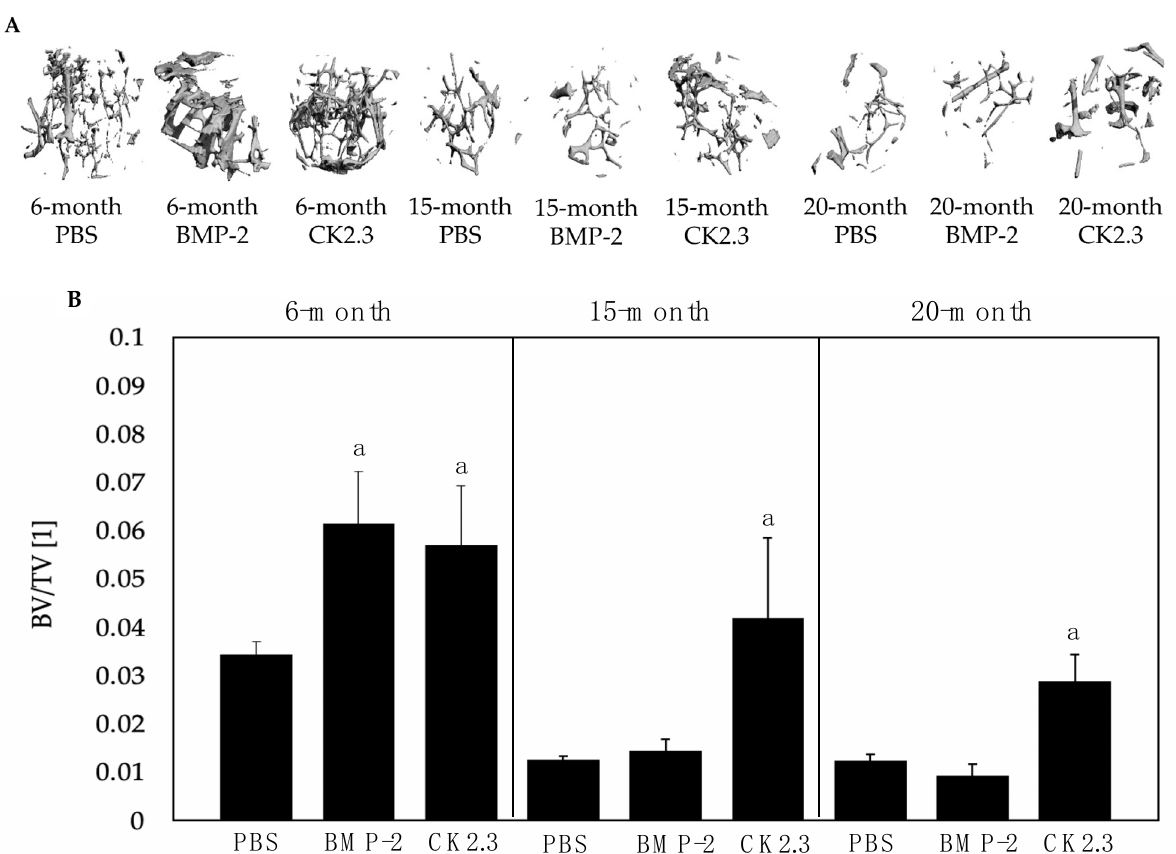
Figure 4. µ CT analysis of trabeculae of mice femurs. ( A ) µ CT images were obtained of femurs isolated from 6-, 15-, and 20-month-old mice stimulated with PBS, BMP-2, and CK2.3 ( N = 5/experimental group); 255 scans were taken of each bone and were reconstructed using a 200–1000 threshold. The 3D images were analyzed to obtain BV/TV. Representative images are displayed. ( B ) Bars charts were constructed displaying the mean BV/TV for each experimental group. Error bars represent standard error of the mean, and “a” signifies statistical significance and represents bar 1 (PBS). Scans were conducted in duplicate and statistical analyses were performed using the Fisher’s Exact statistical test.